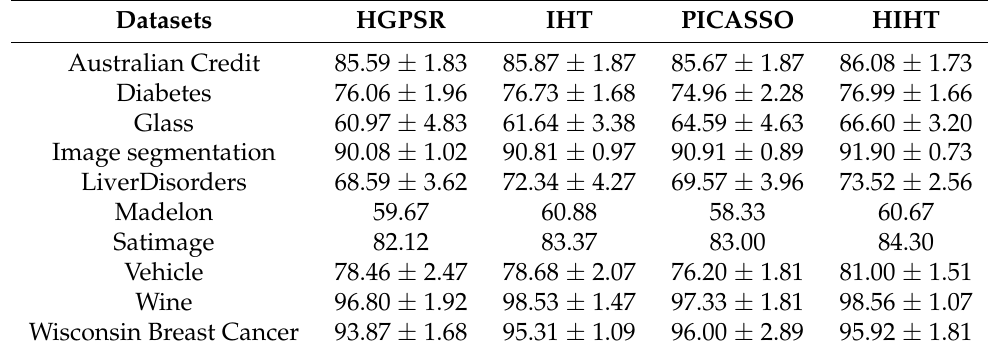
Table 4. Recognition Results of the Proposed Method Using different sparse coding